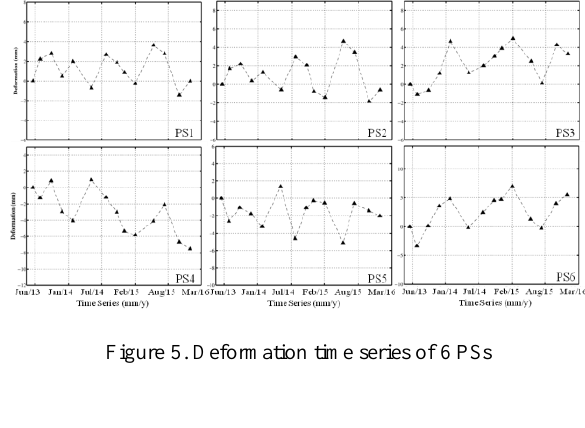
Figure 5. Deformation time series of 6